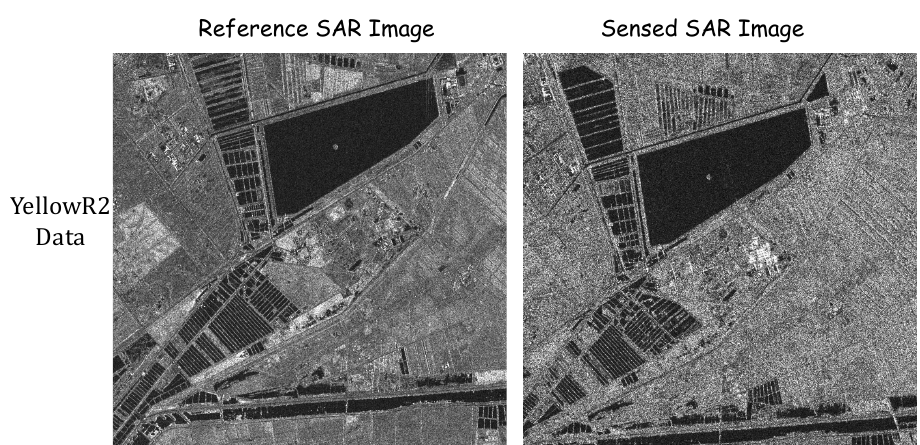
Figure 7. Reference and Sensed Images of YellowR2